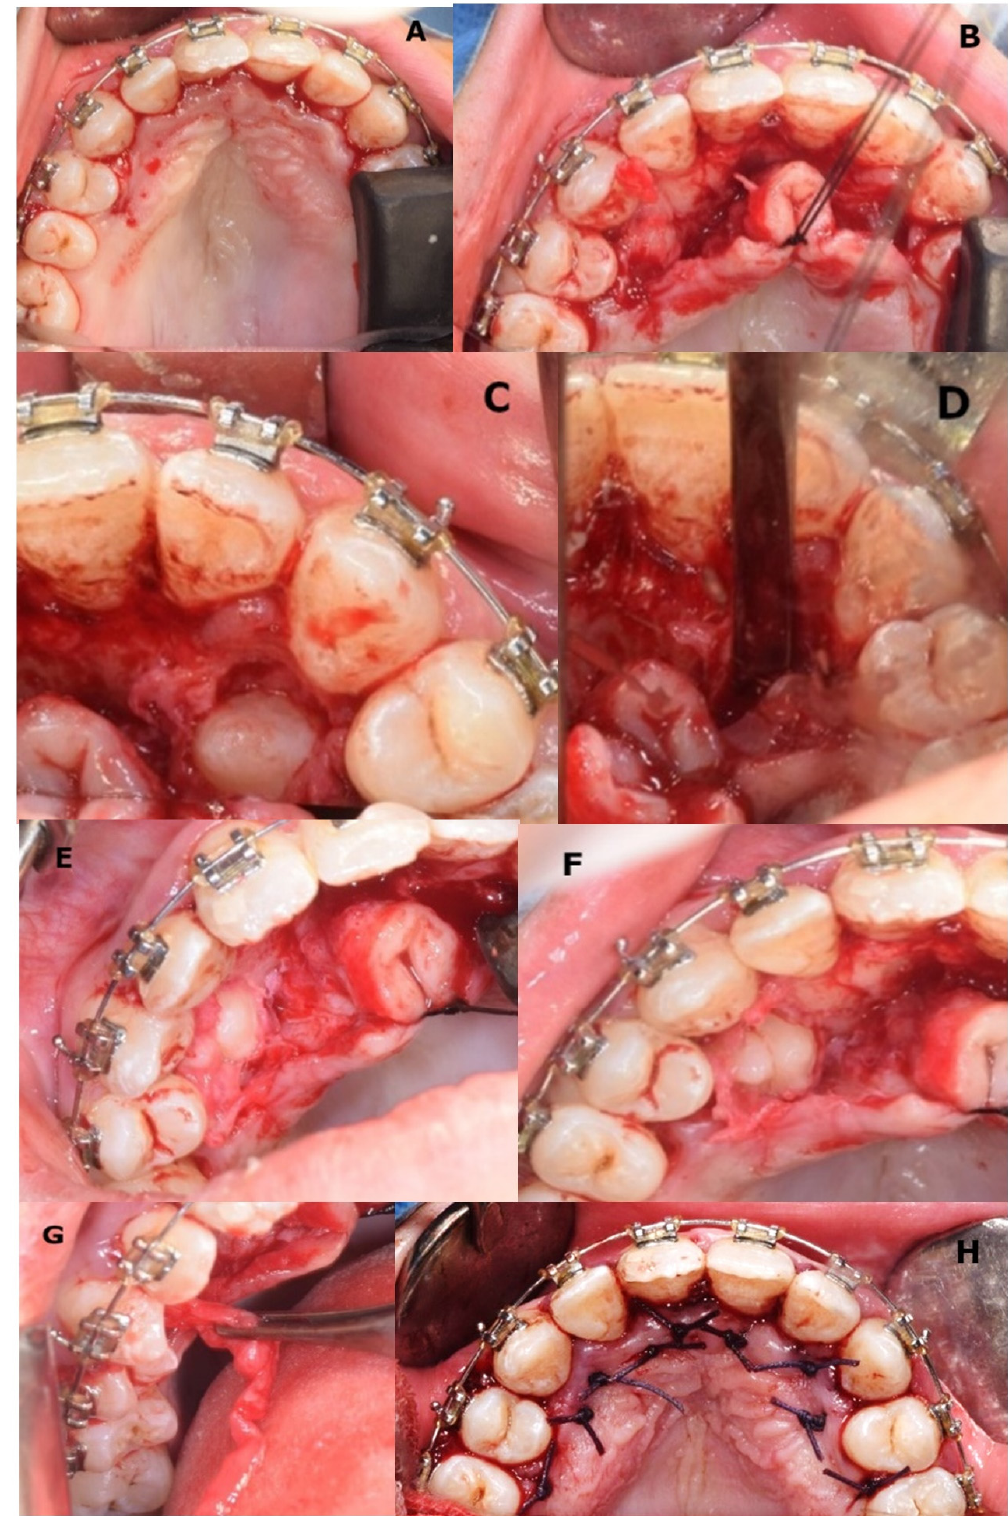
Figure 17 ( A – H ). Supplementary canine extractions 31 July 2020 (22-year-old): ( A ) full-thickness incision between mesial upper first premolars; ( B ) raising of the full-thickness flap and retention with 2-0 silk suture; ( C ) exposure of supplementary left canine; ( D ) extraction site of supplementary left canine; ( E ) partial exposure of supplementary right canine; ( F ) exposure of supplementary right canine just before extraction; ( G ) follicular sac removal; ( H ) suture of the flap.